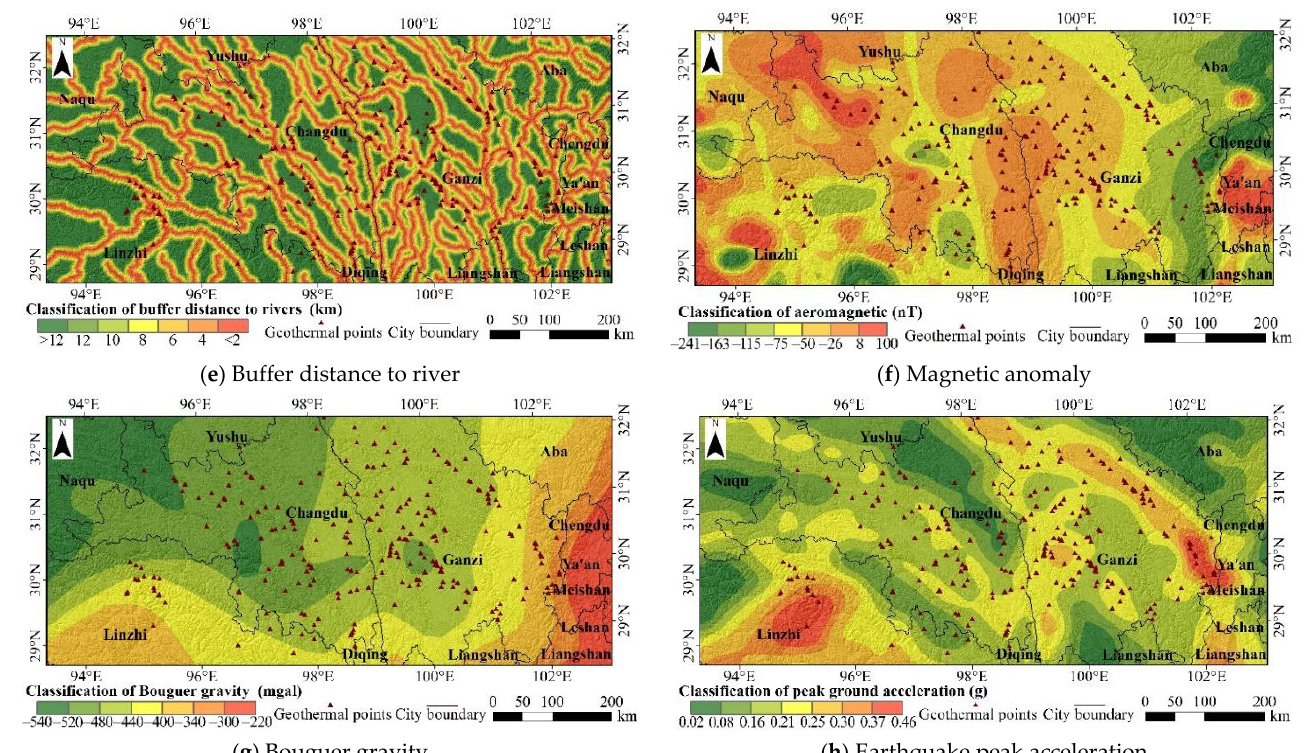
Figure 6. Factor reclassification maps.